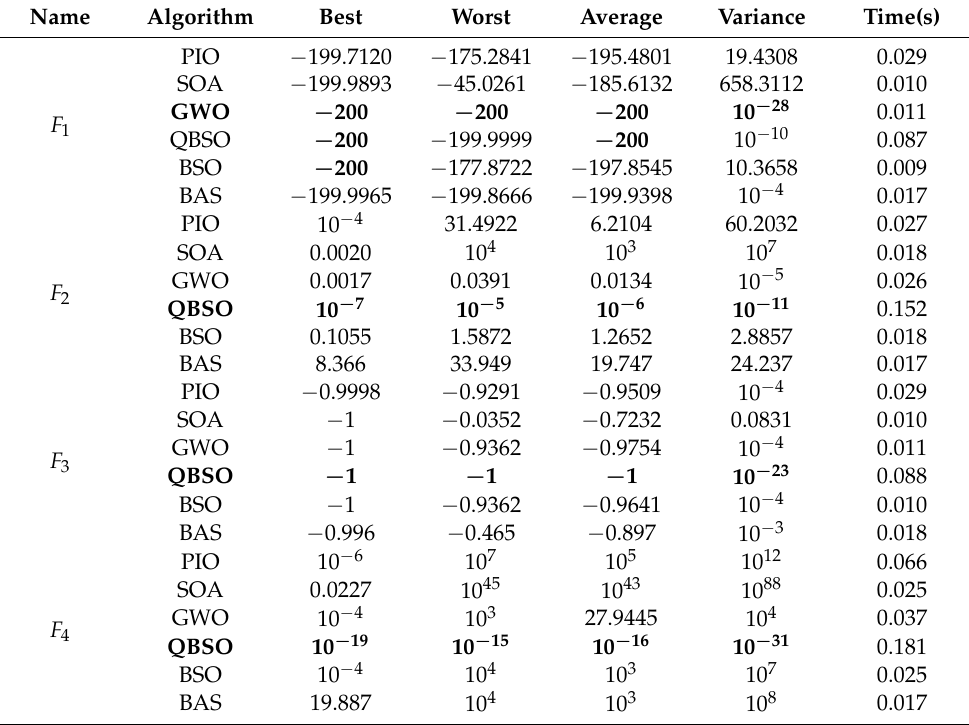
Table 2. Results of the unimodal benchmark function experiments (population size =